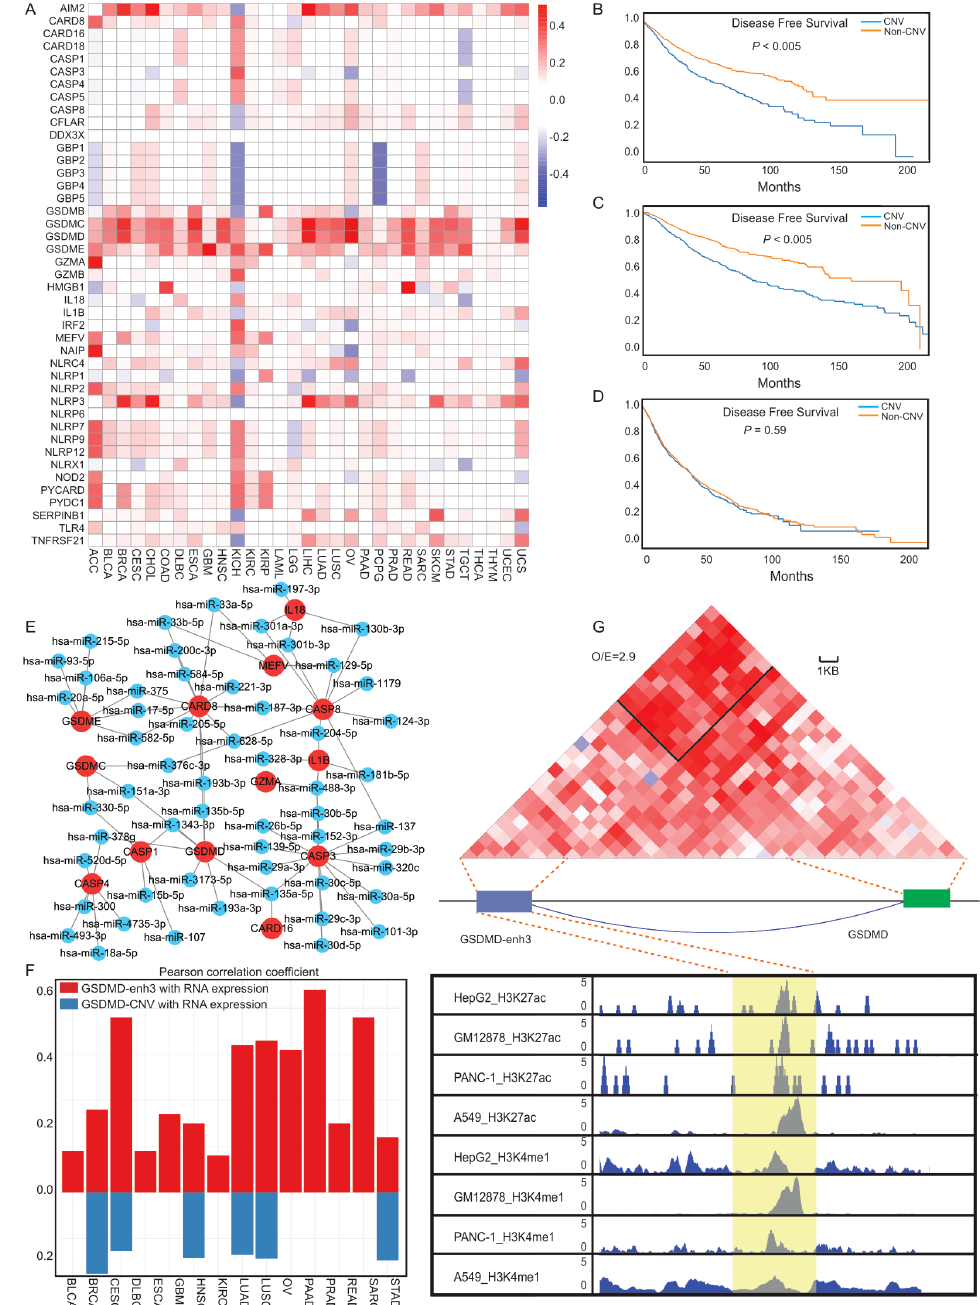
Figure 3. Genome elements on transcriptional regulation of PRGs. ( A ) The heat map showing the CNV changes in PRGs in each cancer type. ( B – D ) Kaplan-Meier curves for the CNVs of samples in the high-score ( B ), low-score ( C ), and middle-score ( D ) groups. ( E ) The miRNA-mRNA network for PRGs: the red circles are genes, and the blue circles are miRNAs (Pearson correlation > 0.4, FDR < 0.05). ( F ) The upper red histogram shows the correlation between the enhancer (GSDMD-enh3) and GSDMD gene expression, and the lower blue histogram shows the correlation between CNV and GSDMD gene expression. The correlation statistics adopt the Pearson correlation coefficient statistical method. ( G ) Hi-C results demonstrating the combination of GSDMD and the GSDMD-enh3 at the chromosomal level (upper panel). ChIP-Seq signals of active enhancers (H3K27ac and H3K4me1) in different cancer cell lines (HepG2, GM12878, PANC-1, and A549) (lower